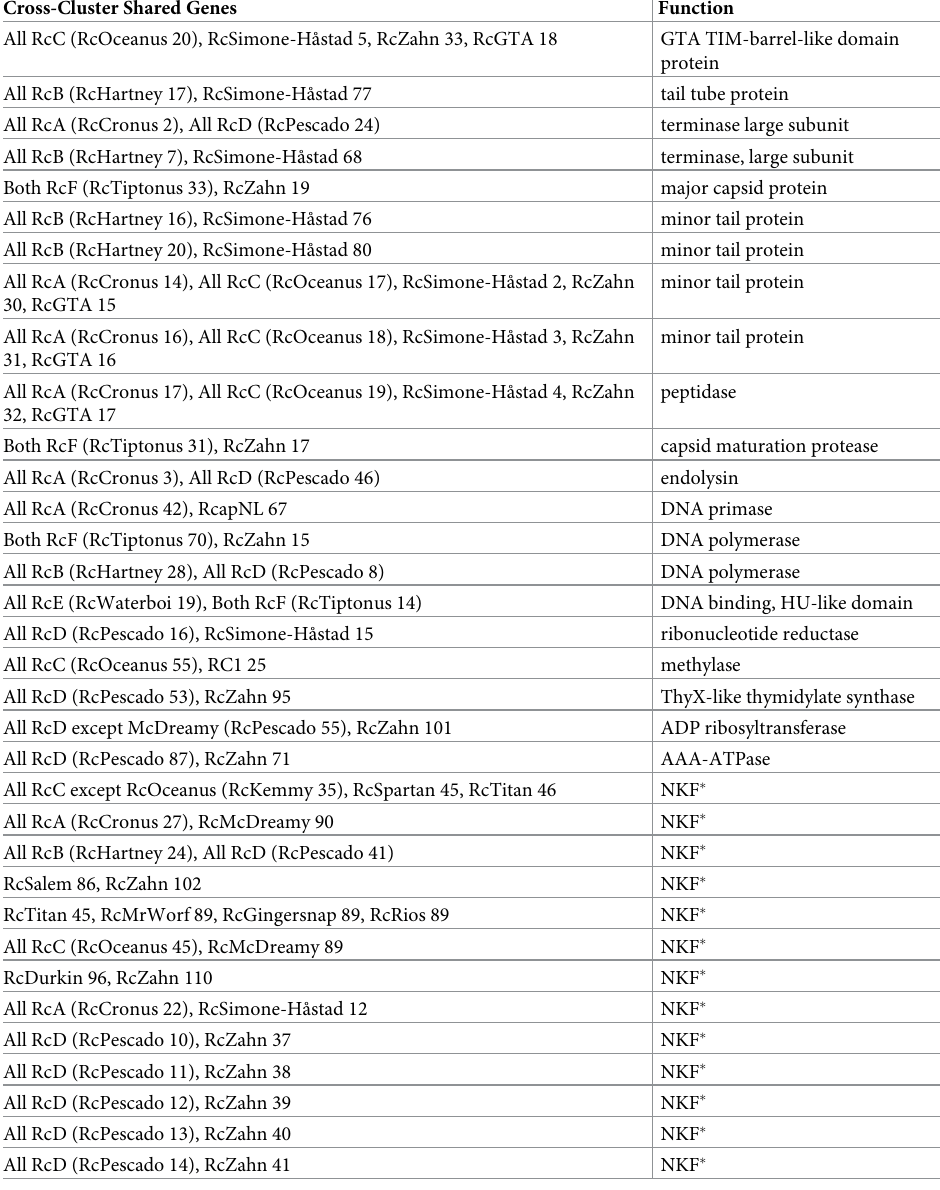
Table 5. Genes shared among R . capsulatus